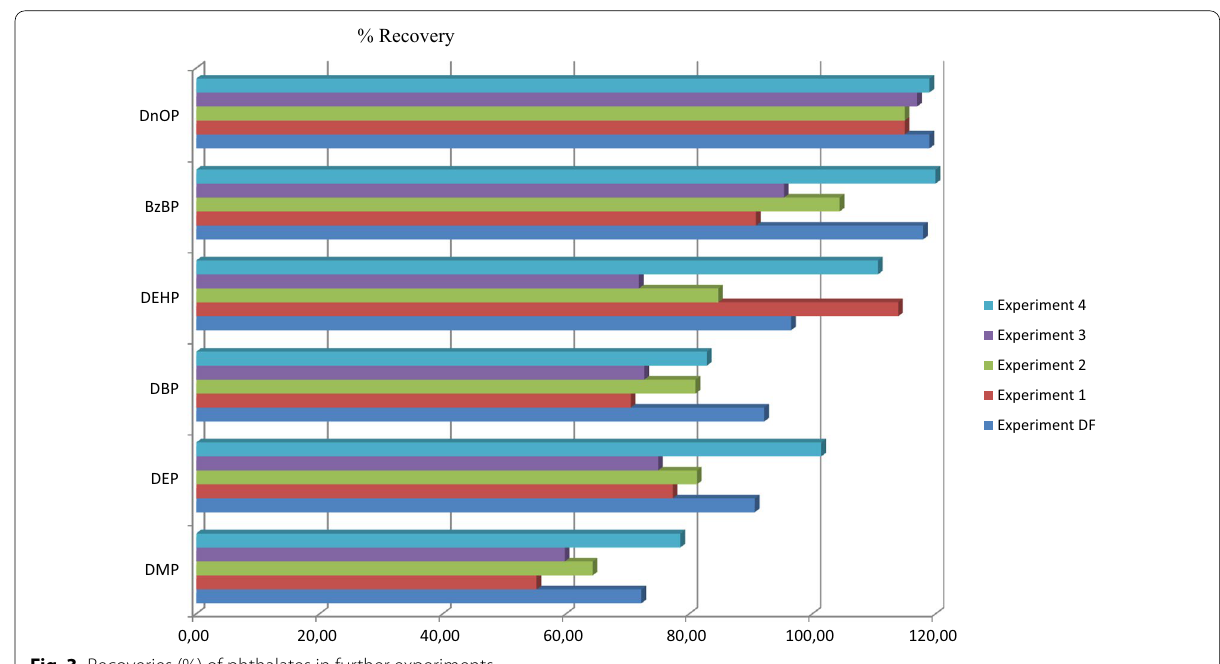
Fig. 3 Recoveries (%) of phthalates in further experiments